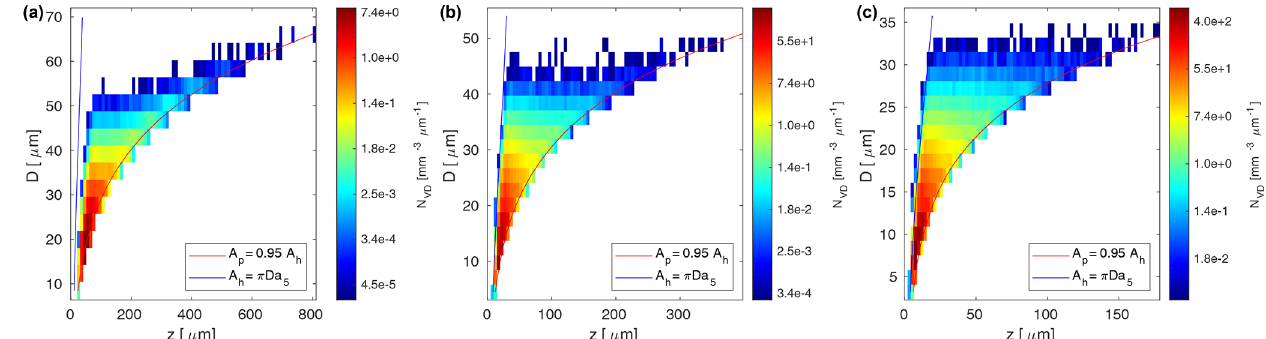
Figure 9. Variability of droplet detection properties in the size–space domain for lens settings of (a) × 1, (b) × 2 and (c) ×